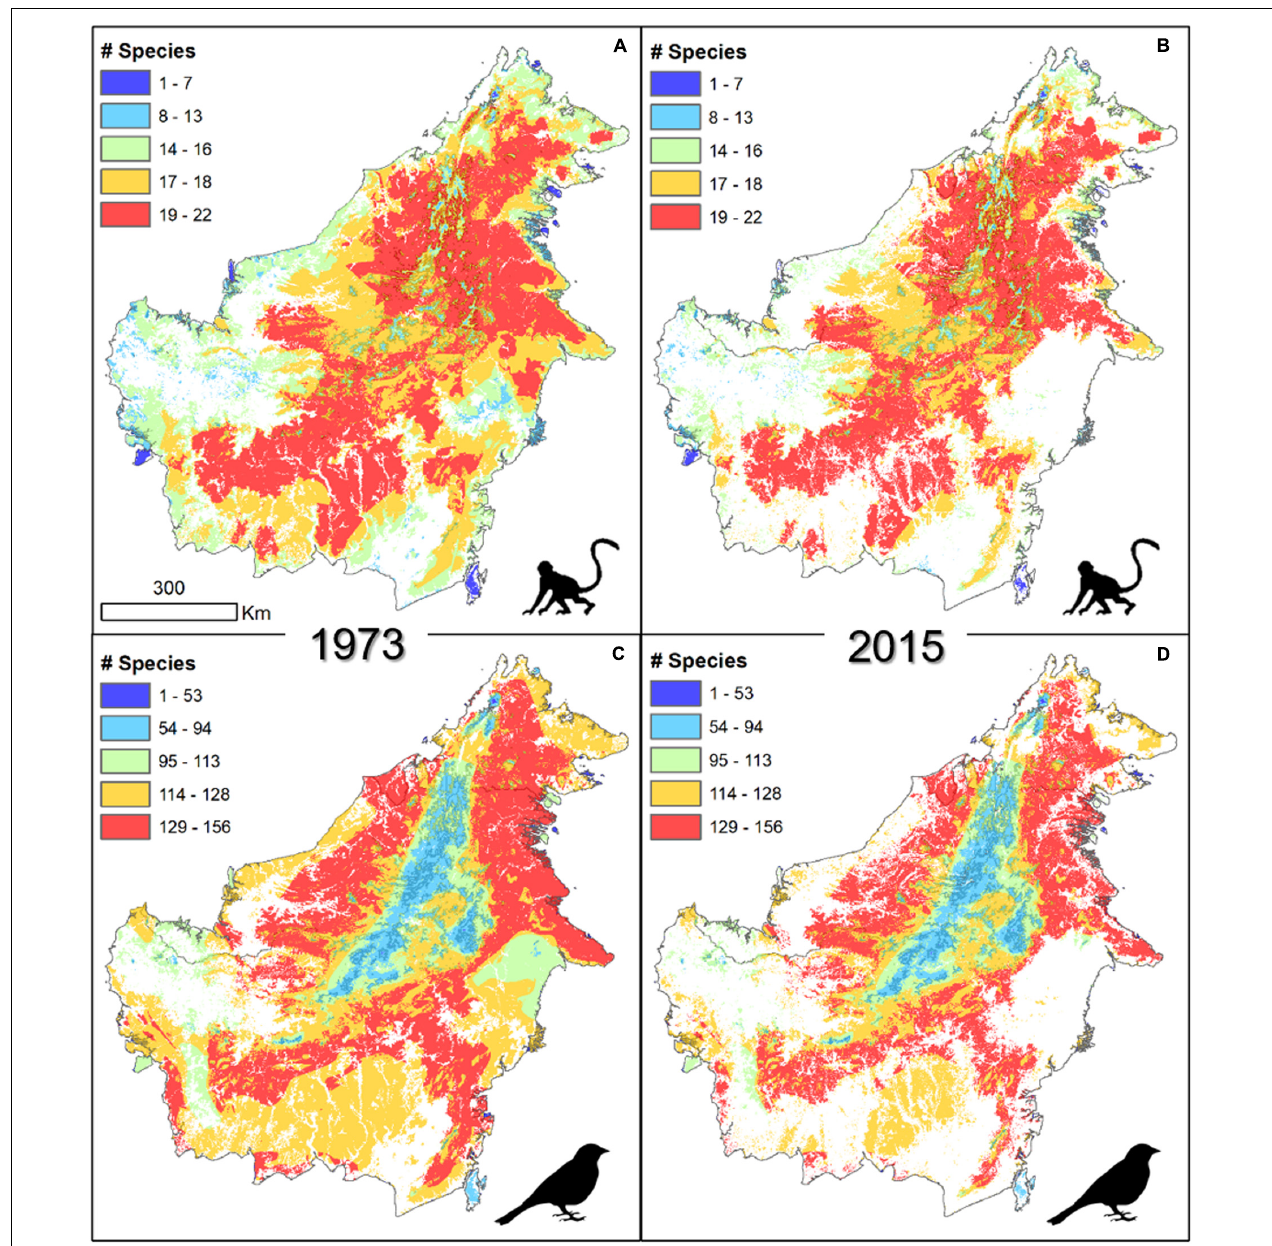
FIGURE 2 | Concentrations of forest vertebrates on the island of Borneo in forested areas in 1973 (A,C) and 2015 (B,D) for mammals ( A,B , n = 29) and birds ( C,D , n =